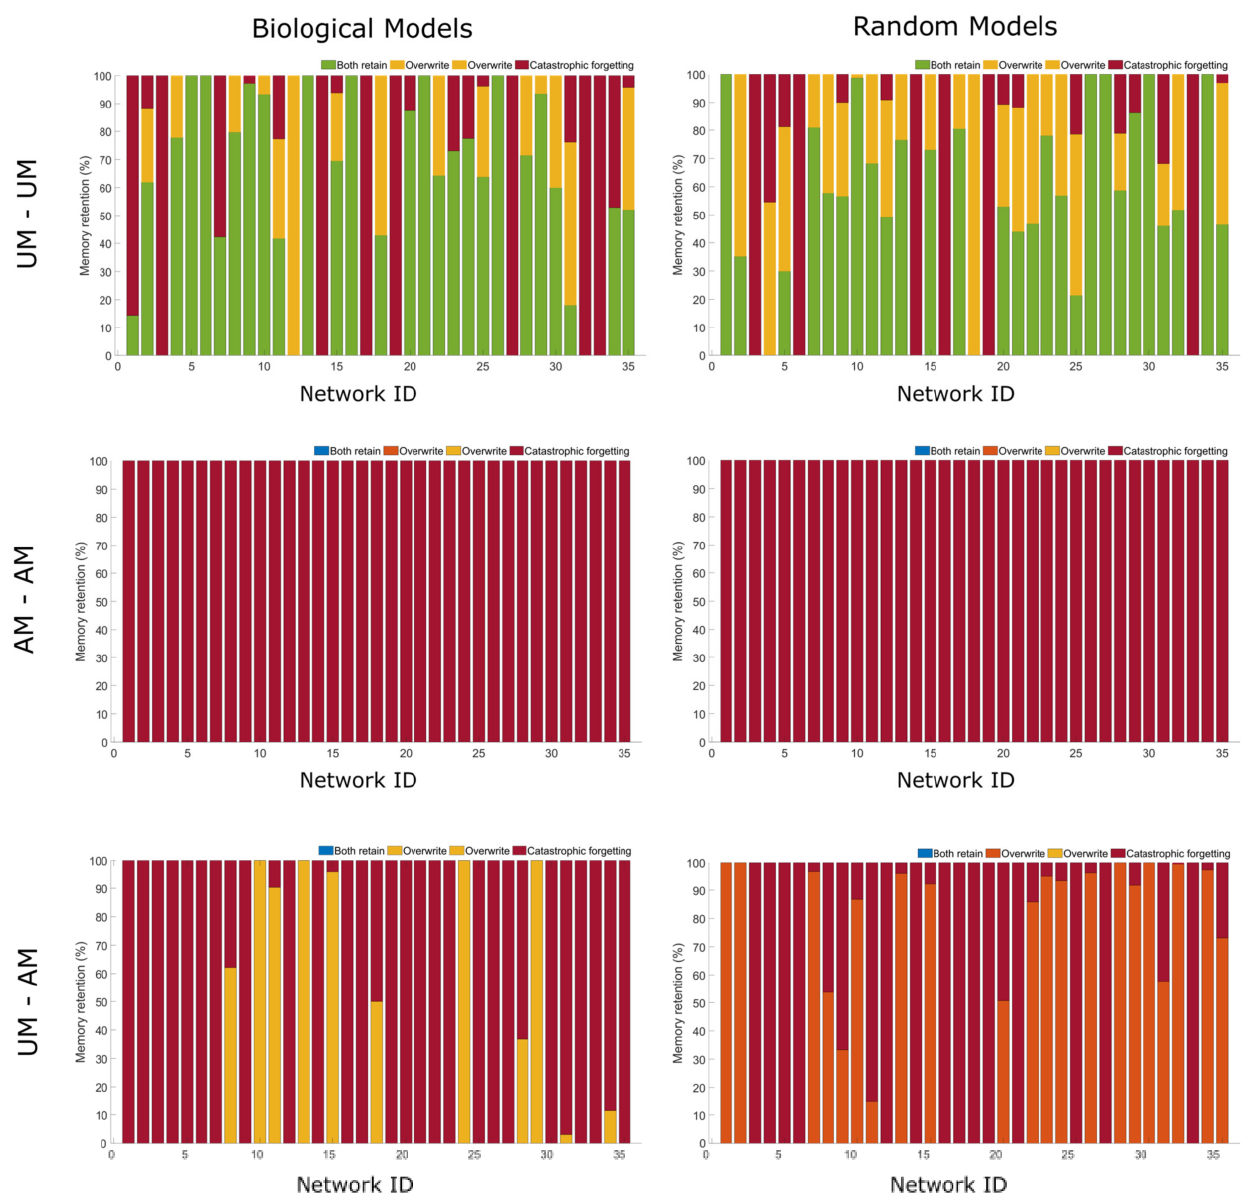
Figure 5. Serial Memories in Biological and Random Models.